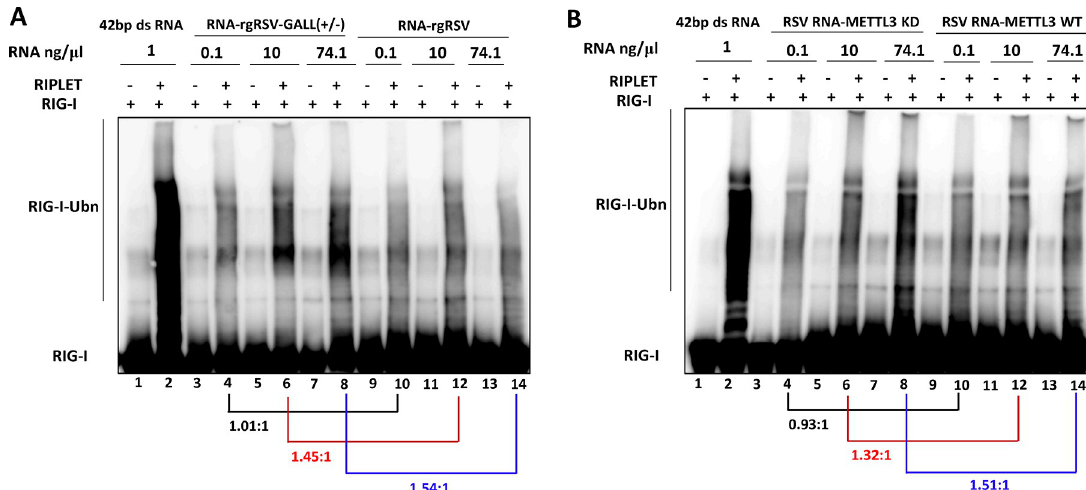
Fig 3. In vitro ubiquitination analysis of RIG-I. (A) rgRSV-GALL(+/-) virion RNA enhances RIG-I ubiquitination (RIG-I-Ubn) compared to rgRSV virion RNA. 1.0 μ M of purified RIG-I was incubated with 1ng/ μ l of 42 bp dsRNA or different doses (0.1, 10, and 74.1 ng/ μ l) of virion RNA from rgRSV-GALL(+/-) or parental rgRSV with or without RIPLET. Ubiquitination of RIG-I was analyzed by anti-RIG-I blot. (B) Virion RNA from METTL3 -KD U2OS cells enhances RIG-I ubiquitination compared to virion RNA from wt U2OS cells. The density of each lane was quantified by Image J. The length of lane used for quantification was indicated by the line in the left side. The ratio between m 6 A-deficient virion RNA and wild type virion RNA at each RNA concentration is indicated. m 6 A-deficient RSV RNA enhances RIG-I ubiquitination Ubiquitination plays essential roles in RIG-I activation as well as the type I IFN signaling path- way. Upon binding to the RNA ligand, RIG-I undergoes a significant conformational change enabling K63-linked ubiquitination at multiple sites that is required to reach full activity. Recent studies have found that RIG-I ubiquitination and activation are dependent on RIPLET [51]. Thus, we compared the abilities of m 6 A-deficient and sufficient RSV RNA in promoting ubiquitination of RIG-I. In this experiment, a 42bp dsRNA was used as a positive control. As expected, incubation of purified RIG-I with 42bp dsRNA triggered strong ubiquitination of RIG-I in the presence of RIPLET ( Fig 3A, lane 2 ). No RIG-I ubiquitination was observed in the absence of RIPLET ( Fig 3A, lane 1 ). As shown in Fig 3A and 3B , RSV RNA promoted RIG-I ubiquitination in a dose-dependent manner only in the presence of RIPLET. The ratio of RIG-I ubiquitination between m 6 A-deficient RSV RNA and WT-RNA was quantified by image J. At an RNA concentration of 0.1 ng/ μ l, the ratio of RIG-I ubiquitination between rgRSV-GALL(+/-) RNA and WT rgRSV RNA is approximately 1.01: 1 ( Fig 3A ). However, a 1.45- and 1.54-fold increase in RIG-I ubiquitination occurred at rgRSV-GALL(+/-) RNA con- centrations of 10 and 74.1 ng/ μ l, respectively ( Fig 3A, compare lanes 6 and 12, and lanes 8 and 14 ). Similarly, virion RNA from METTL3 -KD U2OS cells induced 1.32 and 1.51-fold increases in RIG-I ubiquitination at RNA concentrations of 10 and 74.1 ng/ μ l, respectively, compared to virion RNA from wt U2OS cells ( Fig 3B, compare lanes 6 and 12, and lanes 8 and 14 ). To further confirm these results, a separate ubiquitination assay was carried out using RNA concentrations ranging from 2 to 150 ng/ μ l ( S5 Fig ). Similarly, there was no difference in RIG-I ubiquitination at a relatively low dose of RSV RNA (2 ng/ μ l) ( S5A Fig ). A 1.38–1.90 fold increase in RIG-I ubiquitination was observed for RNA from METTL3 -KD cells ( S5B Fig ) and rgRSV-GALL(+/-) RNA ( S5C Fig ) at concentration of 50–150 ng/ μ l compared to WT RNA. These data demonstrate that m 6 A-deficient RSV RNA promotes RIG-I ubiquitination.